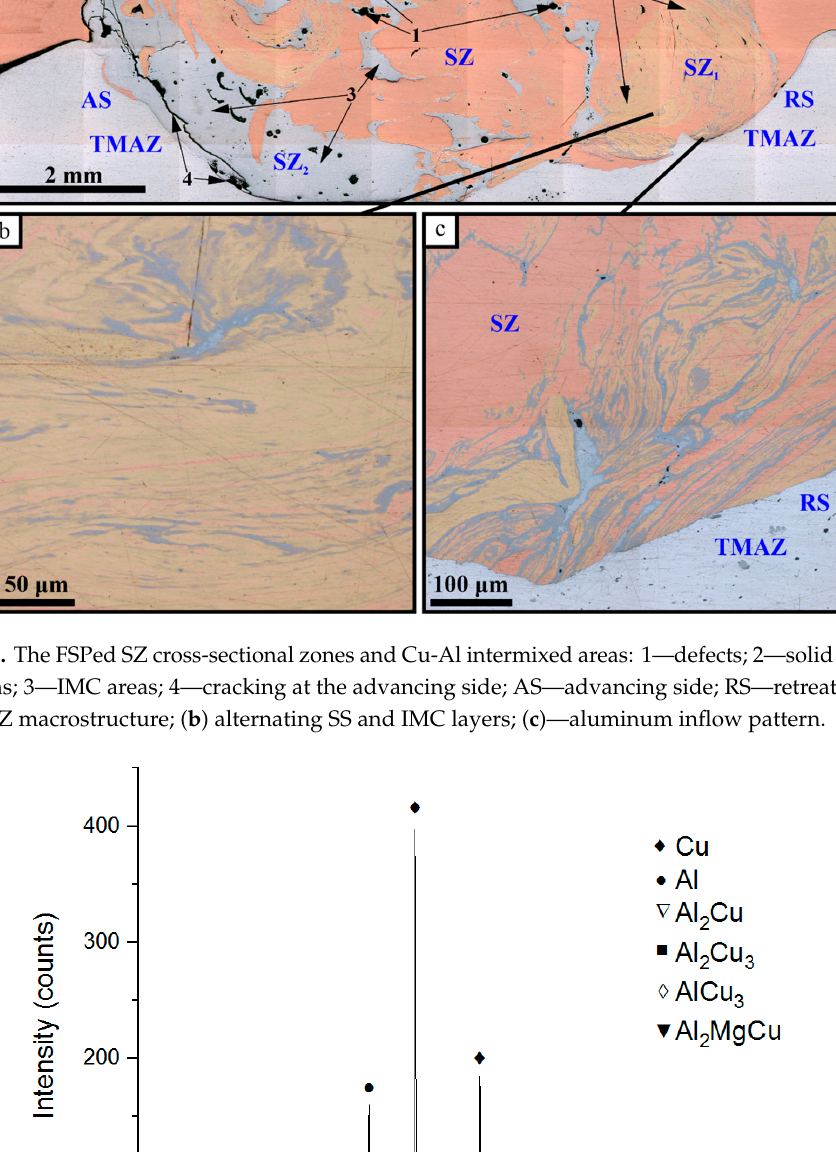
Figure 4. The SEM BSE images of SZ microstructures after a single-pass FSP on the Al-Cu sandwich: ( a ) SS/IMC interface; ( b ) stir zone macrostructures; ( c ) column IMCs; ( d ) IMCs of different compositions; ( e ) substrate/stir zone boundary; ( f ) mixed IMC + SS zone. The IMC layers formed at the Al/Cu interfaces on the Cu-rich side of SZ are composed of 2 to 5 μ m in size Al 2 Cu 3 and AlCu 3 IMCs (Figure 4a,d). The mean size of the Al 2 Cu 3 and AlCu 3 particles in these IMCs is about 300 nm. The presence of these phases is confirmed by the results of XRD (Figure 3), TEM (Figure 5) and EDS (Table 2, spectra 4–7). The interfaces between fine-crystalline copper and IMCs are shown in Figure 5a as well as Al/Al 2 Cu eutectics located in between the Al 2 Cu particles. The selected area electron diffraction (SAED) pattern obtained from the area in Figure 5a shows the reflections, which can be identified as